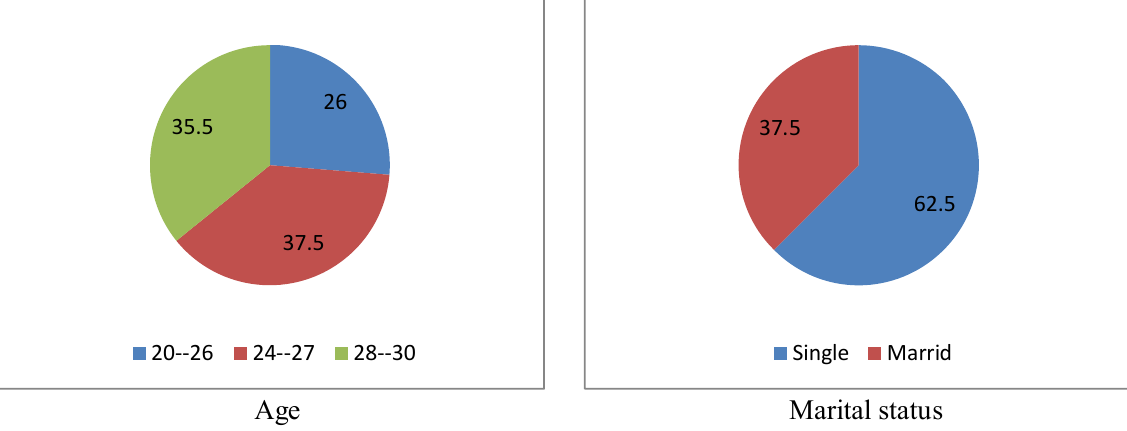
Fig. 1. Personal characteristics of the participants